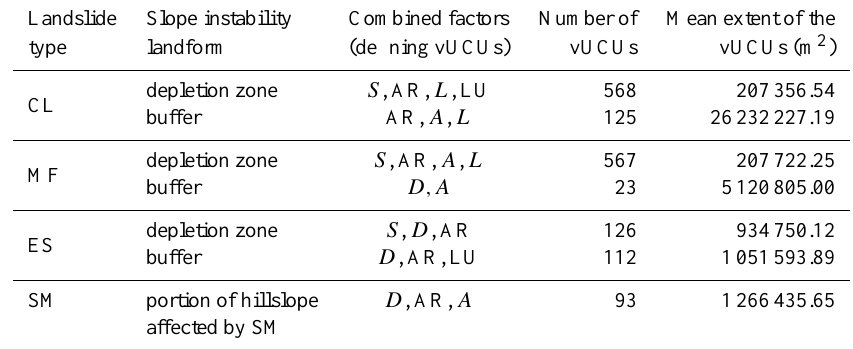
Table 3. Number and mean extent of the vUCUs of each susceptibility zonation described in the